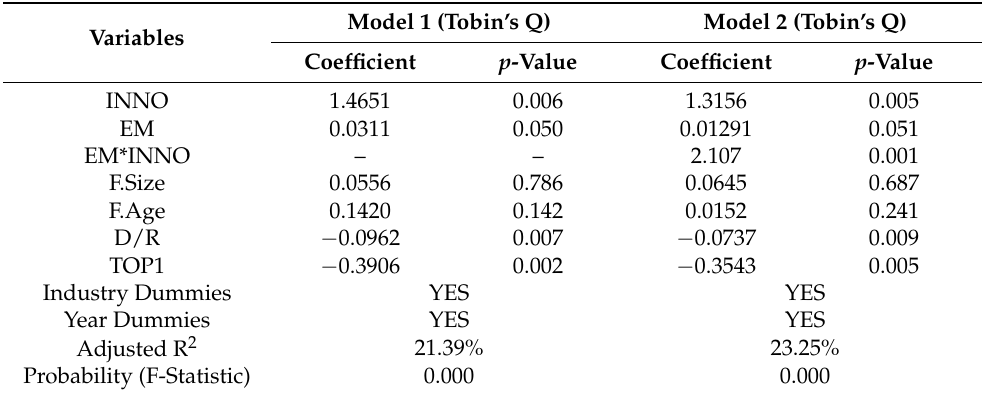
Table 3. Regression